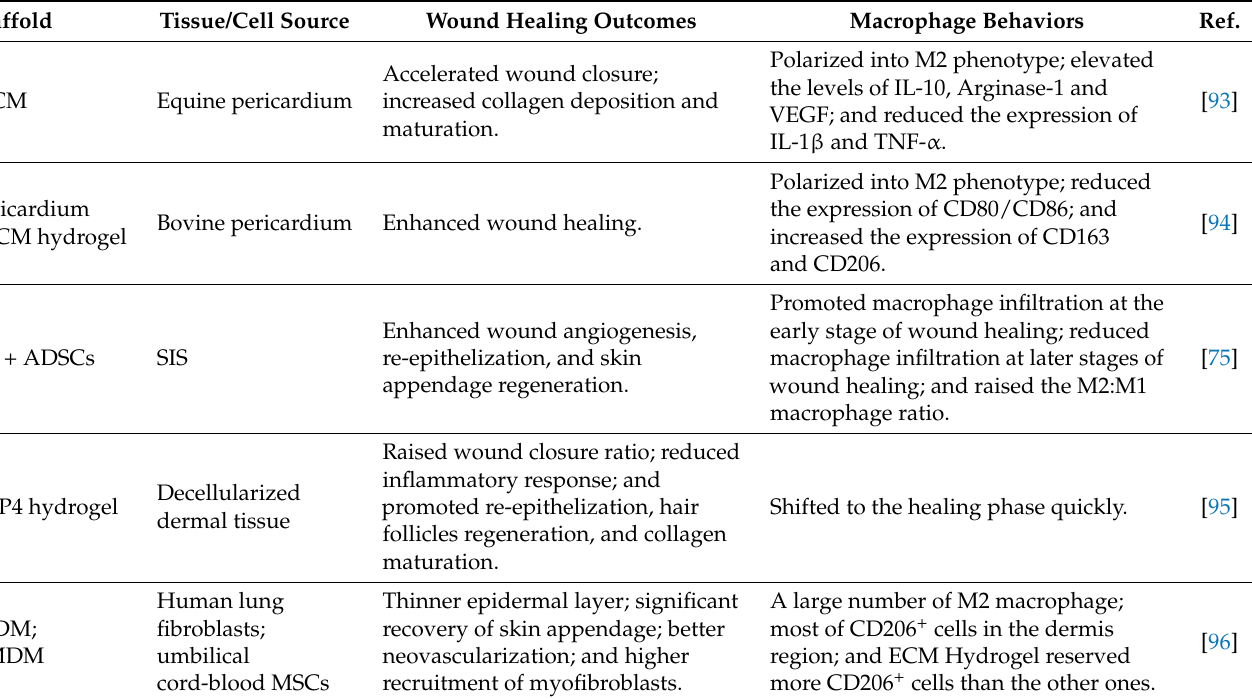
Table 1. ECM-based scaffolds capable of modulating macrophage function to promote skin wound